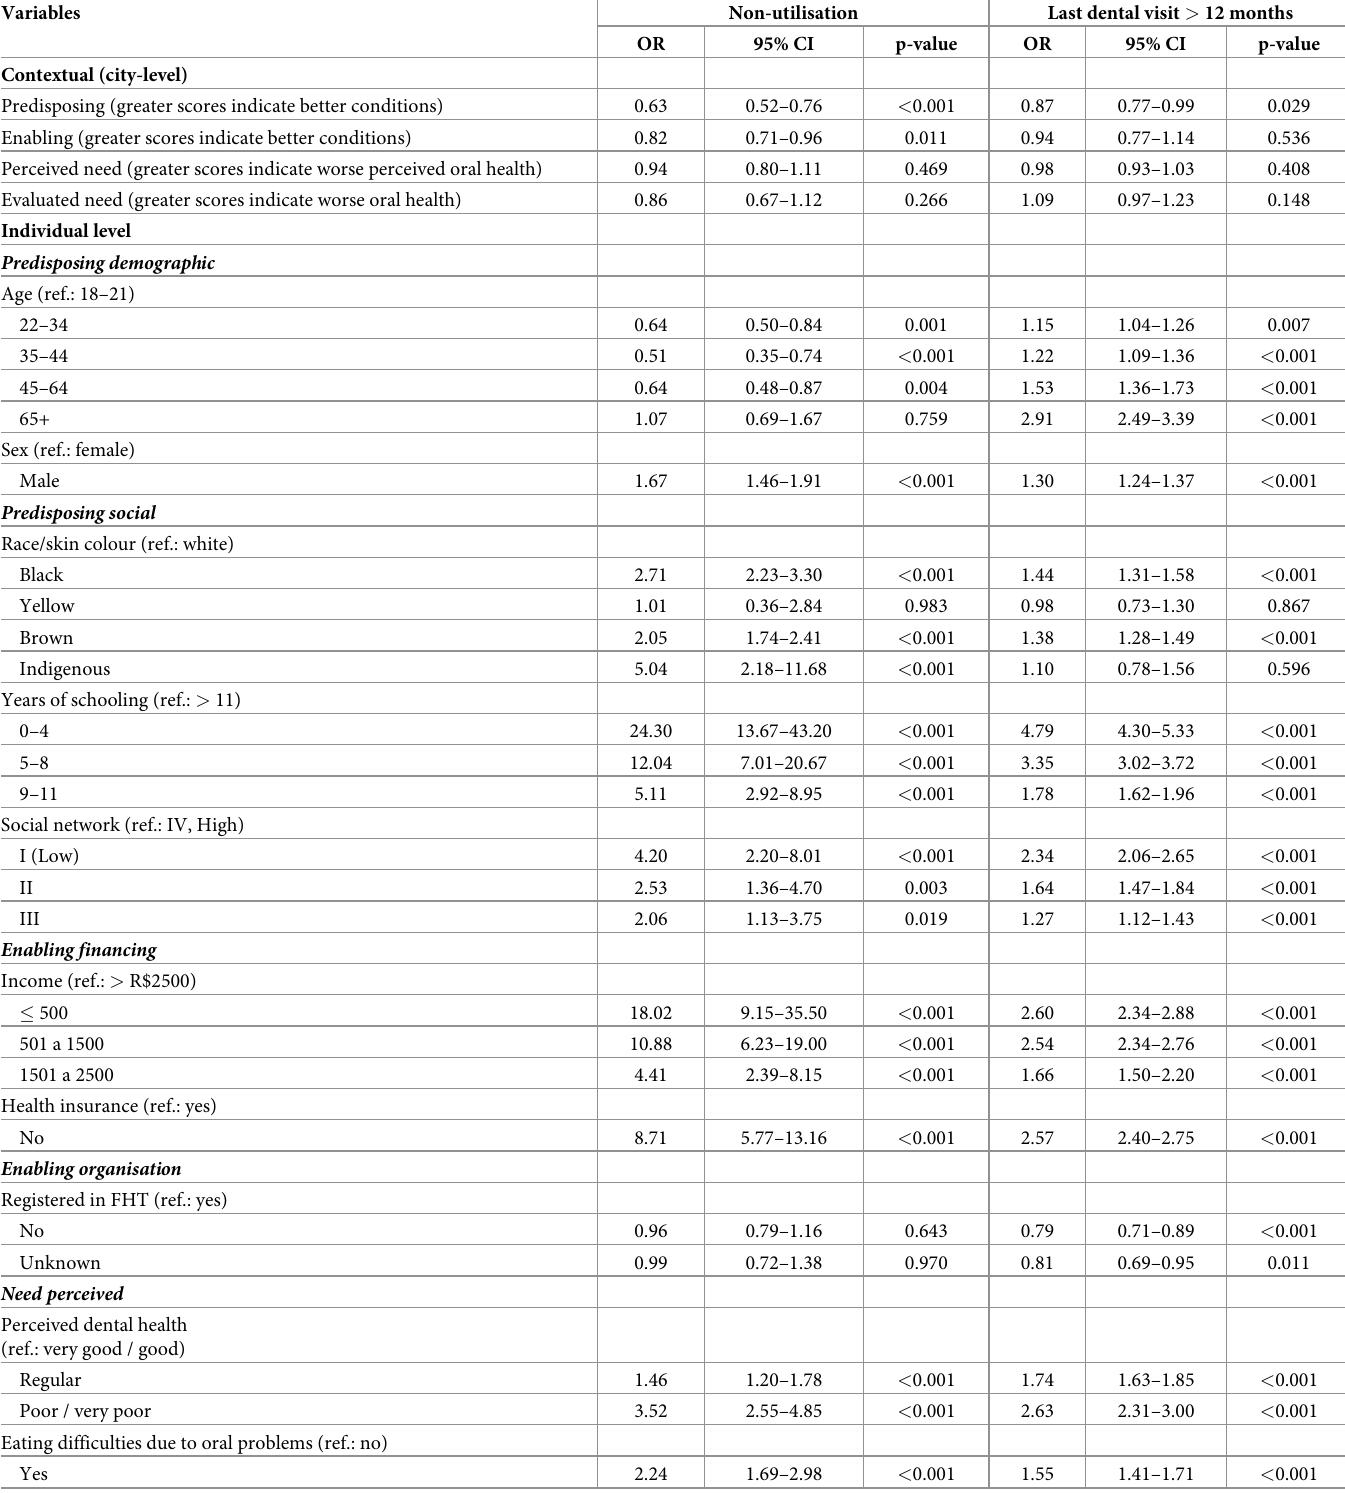
Table 3. Bivariate analyses between independent variables and non-utilisation of dental services and last dental visit over 12 months ago, Brazil, State capitals,